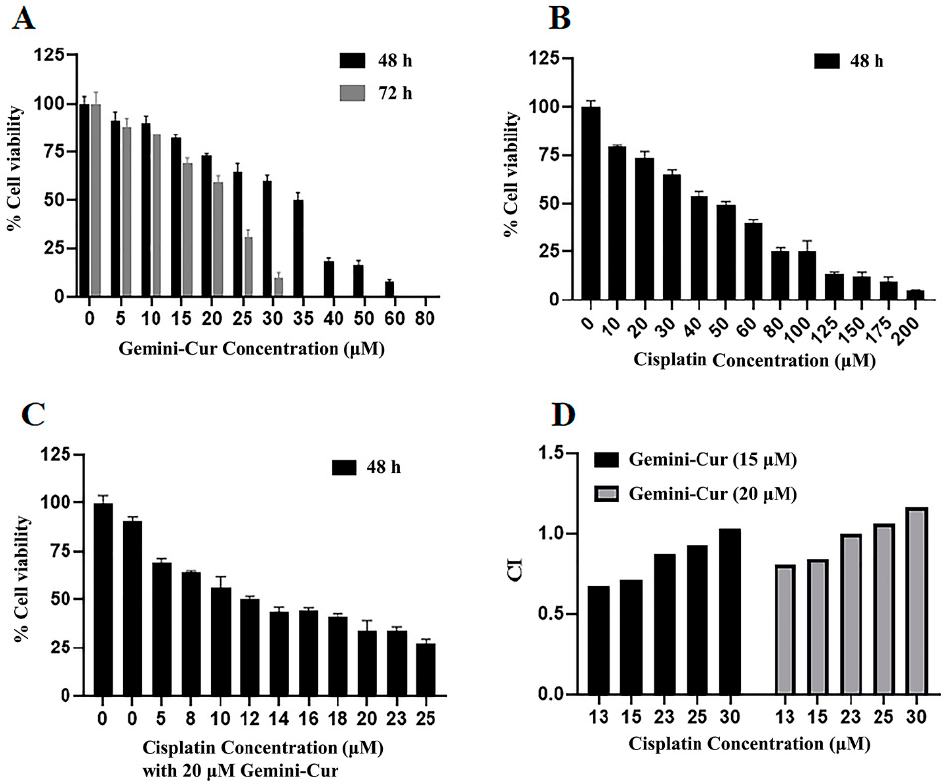
Figure 2. Effect of Gemini curumin and cisplatin on the viability of MDA-MB-231 cells in vitro. MDA-MB-231 cells were grown and treated with Gemini-Cur ( A ), Cisplatin ( B ) and Gemini-Cur/Cis ( C , D ). 15 and 20 μ M of Gemini-Cur combined with serial concentrations of cisplatin. Data represent mean ± standard deviation of three independent experiments. CI: Combination index.